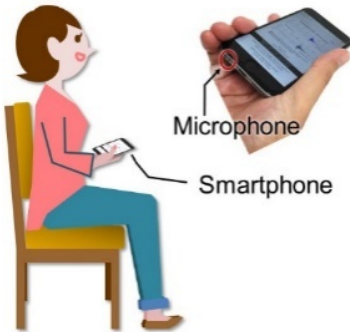
Figure 5. Non-contact cough strength evaluation method. The smartphone (iPhone 6 A1586; Apple, Inc., Cupertino, CA, USA) was held in the left hand while the participant bent the elbow to 90 degrees and the shoulder to 0 degrees and then rotated the arm internally to 45 degrees.